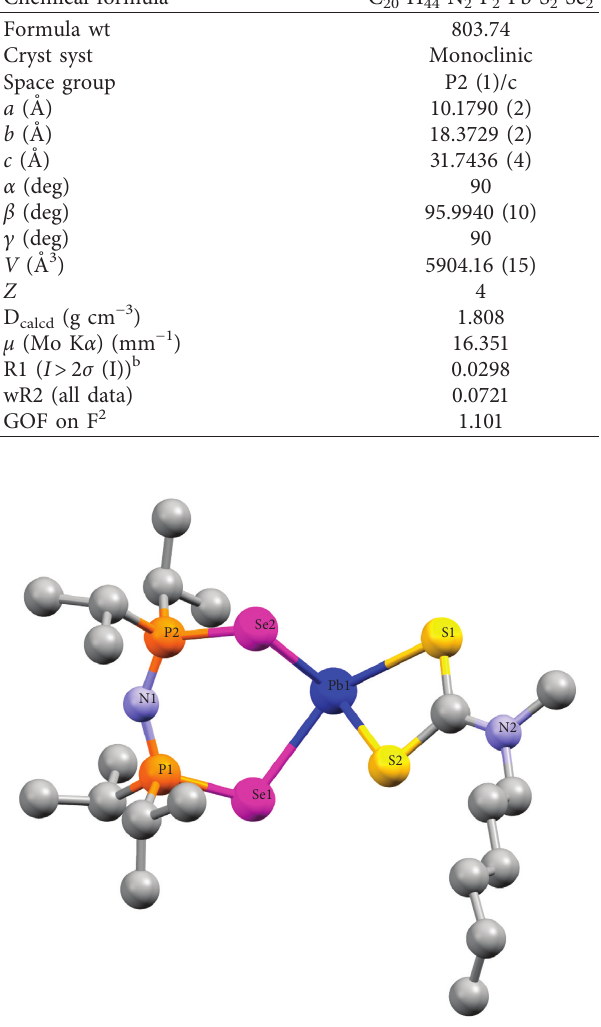
Figure 2: An ORTEP thermal ellipsoid structure of